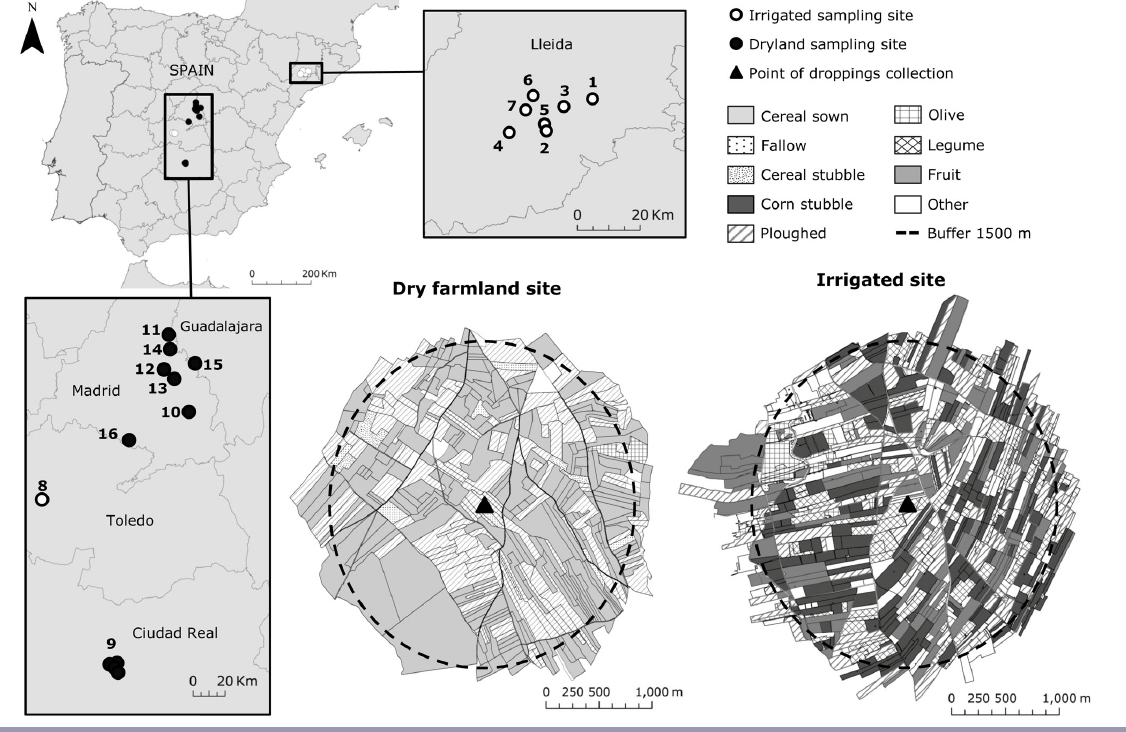
Fig. 1 . Map of the study area showing the irrigated sampling sites (1: Anglesola; 2: Arbeca; 3: Castellnou